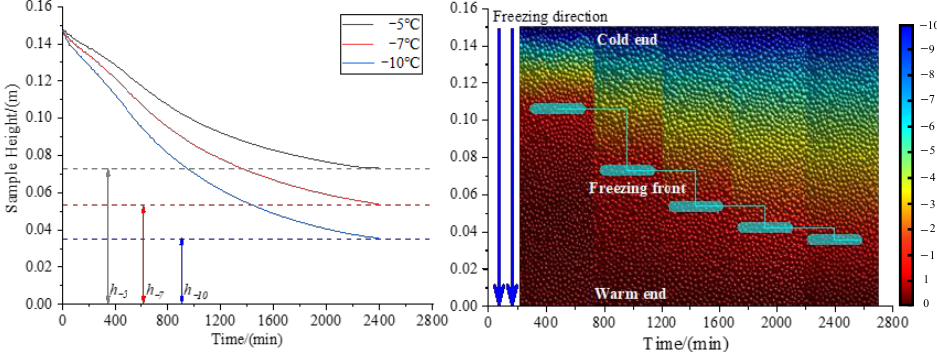
Figure 8. The position of the freezing front varies with time.